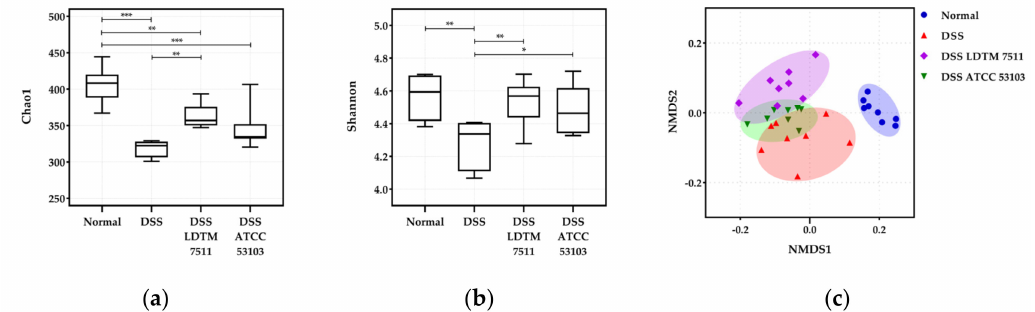
Figure 4. Alpha and beta diversity. ( a ) Chao1; ( b ) Shannon; ( c ) non-metric multidimensional scaling (NMDS) plot of GUniFrac distances. Statistical significance is indicated as follows: * p < 0.05, ** p < 0.01, and *** p < 0.001; n = 8 in each